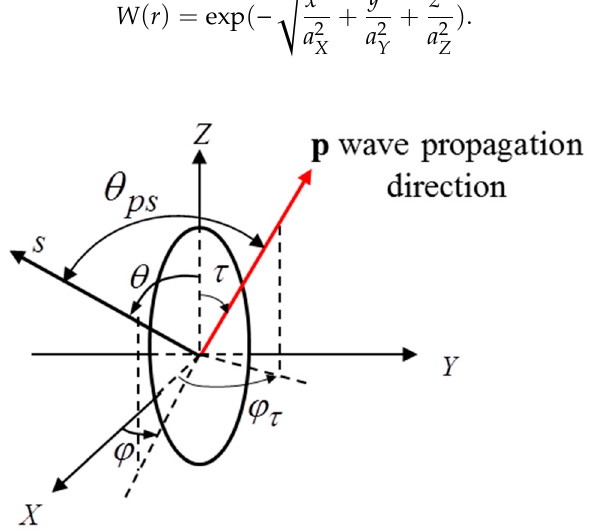
Figure 3. The geometry of an ellipsoidal grain with three main axes a X , a Y and a Z , wave propagation p ( τ , φ τ ) and scattering direction s ( θ , φ ) . Angle θ ps is the angle between p ( τ , φ τ ) and s ( θ , φ )